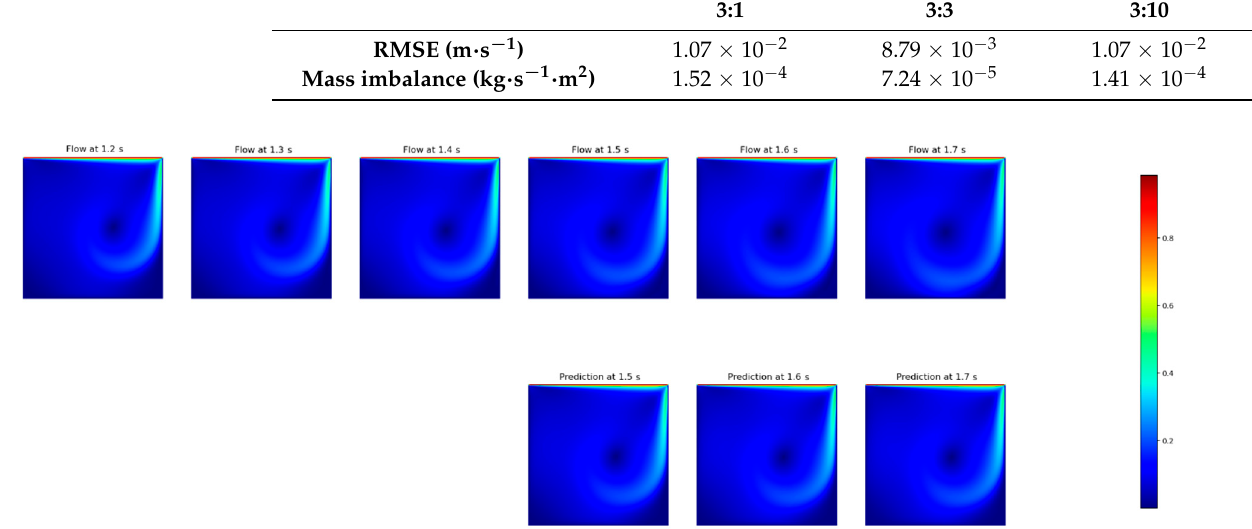
Figure 9. FNO prediction of the resulting speed for the 3 timesteps input and 3 timesteps output. The ground truth plots are above, and the forecasted fields are below.